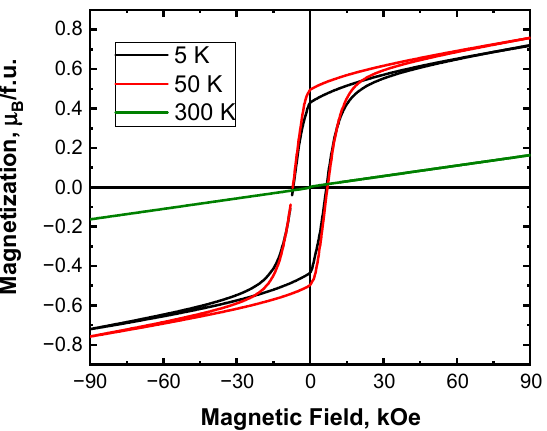
Figure 3. The magnetization versus applied magnetic field of the studied sample recorded at 5 K (black curve), 50 K (red curve), and 300 K (green curve).